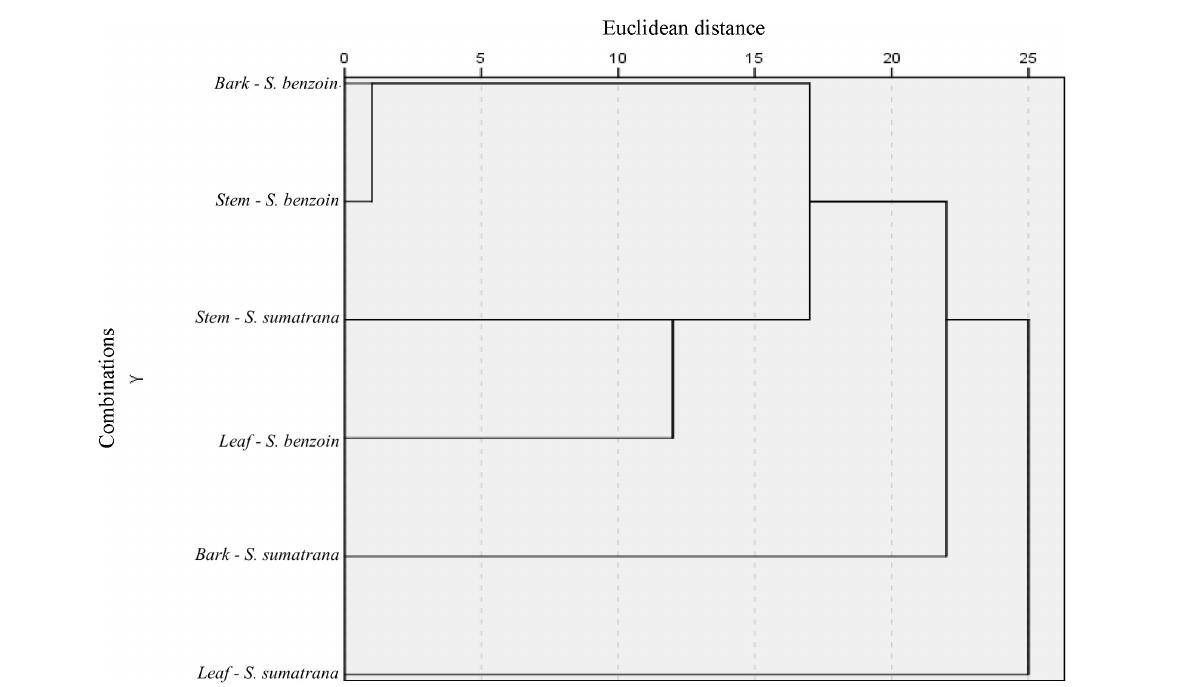
and leaves showed more similarities to each other than to those in the